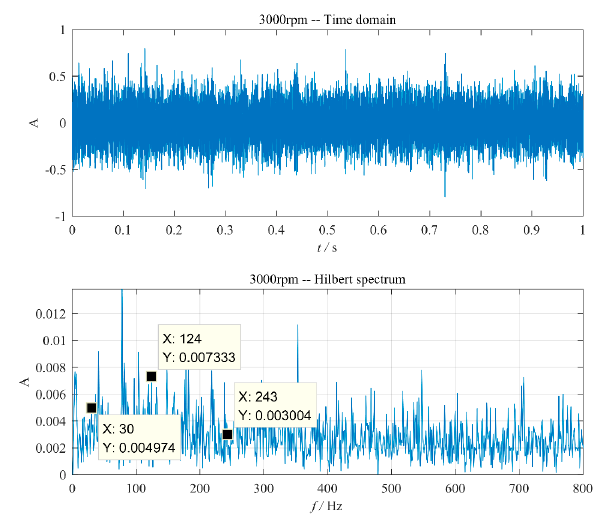
based on improved EEMD.